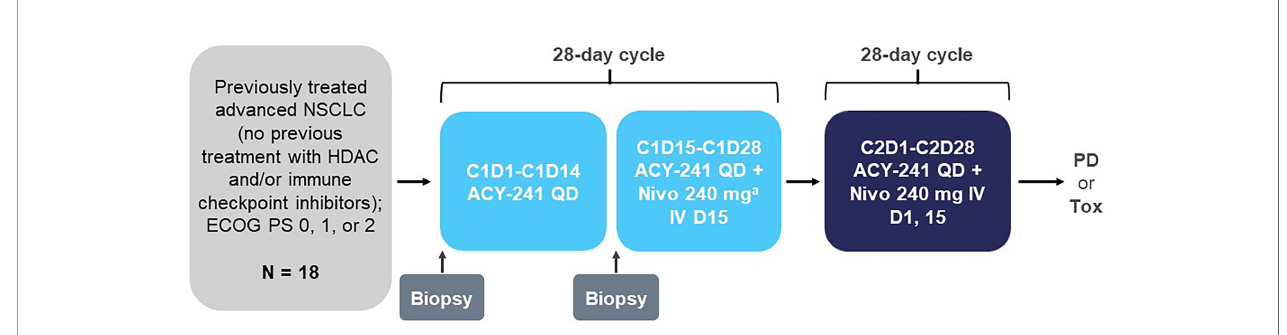
FIGURE 1 | Study design. C, cycle; D, day; ECOG PS, Eastern Cooperative Oncology Group performance status; HDAC, histone deacetylase; IV, intravenous; Nivo, nivolumab; NSCLC, non-small cell lung cancer; PD, progressive disease; QD, once daily; Tox, toxicity. a First dose for the fi rst 2 patients was 3 mg/kg prior to approval of the 240-mg